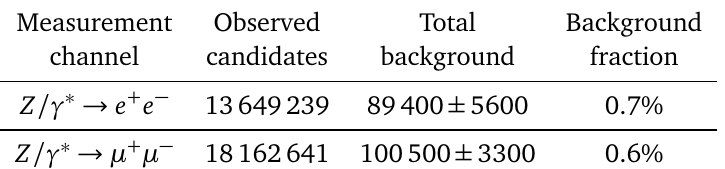
Table 2: Numbers of observed candidates and total background contributions for the Z → ee and Z → µµ decay channels (from [ 3 ]